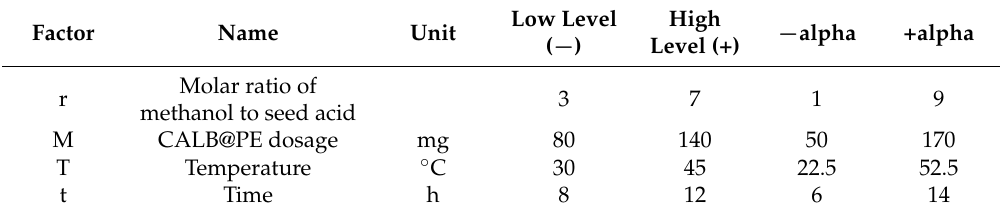
Table 1. Experimental design of each selected variable for biodiesel production.